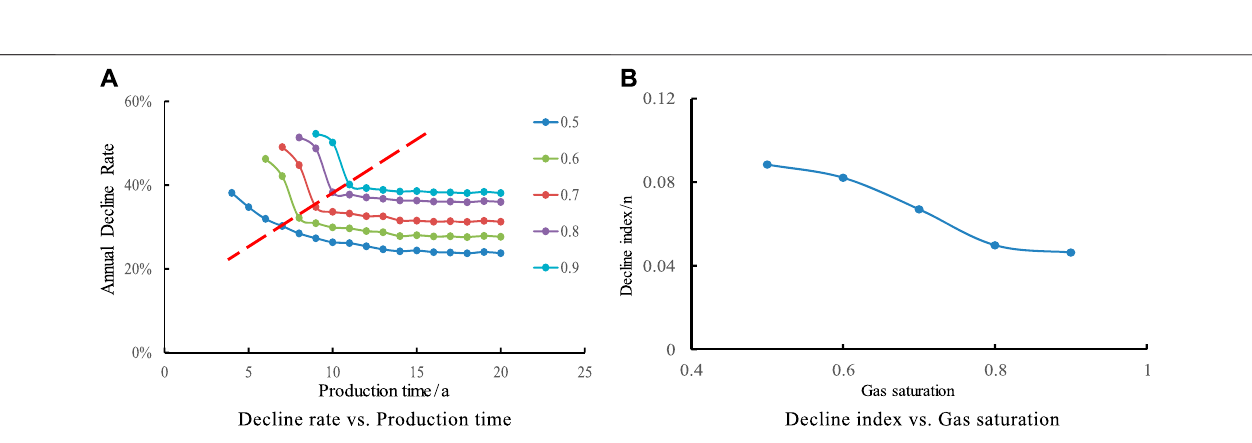
FIGURE 3 | Effect of Gas Saturation on Annual Decline Rate and decline index. (A) Decline rate vs. Production time. (B) Decline index vs. Gas saturation.